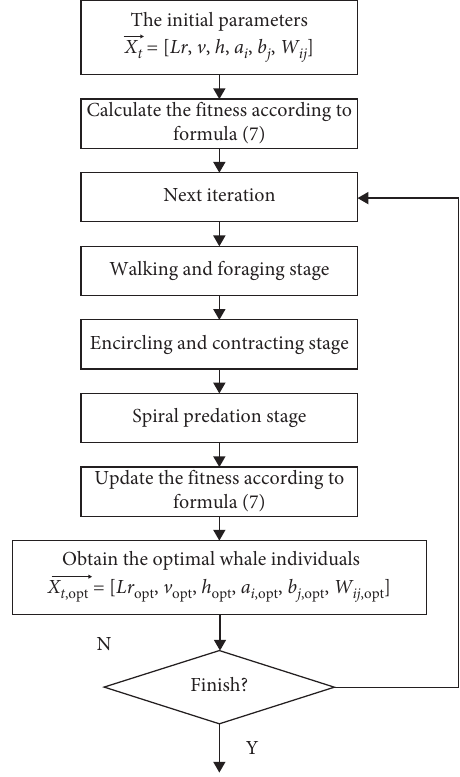
Figure 7: The flowchart of